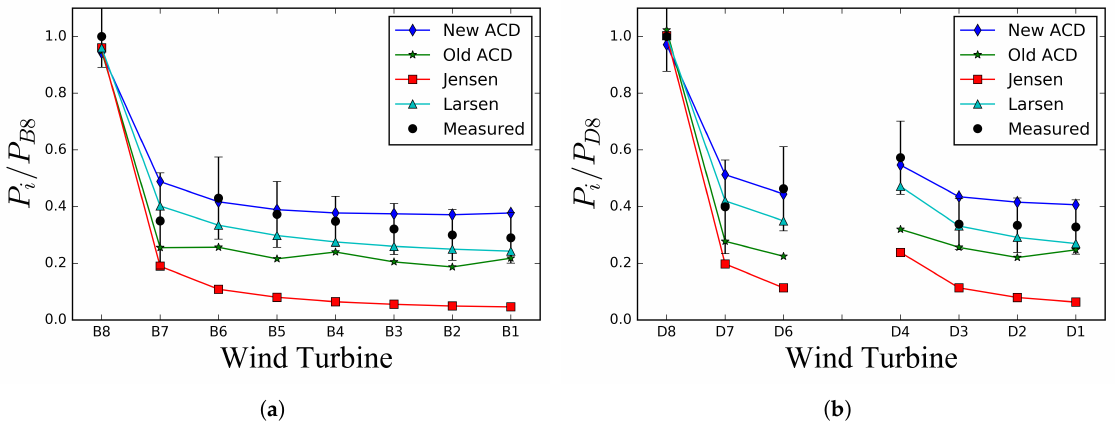
Figure 6. Normalized power production for the 222 ◦ direction ( a ) Column B and ( b ) Column